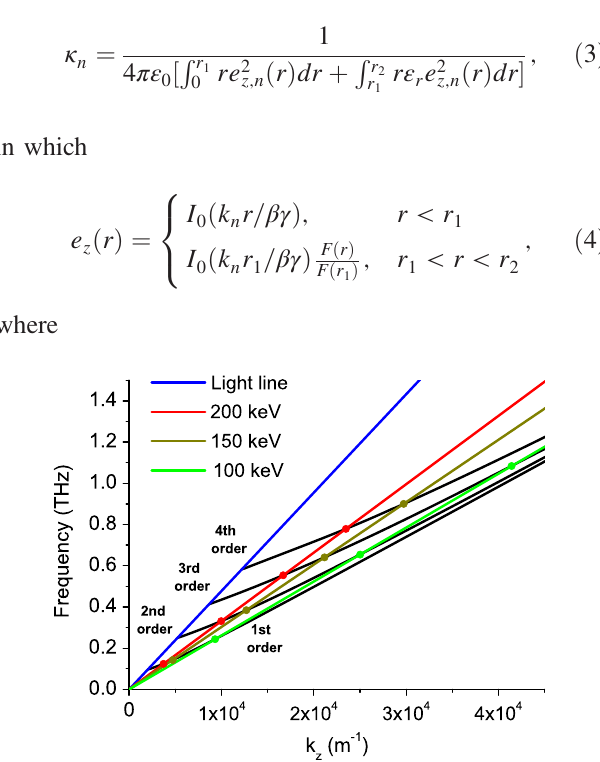
FIG. 2. Dispersion curves of the first four order modes (black lines) and electron beam lines with different